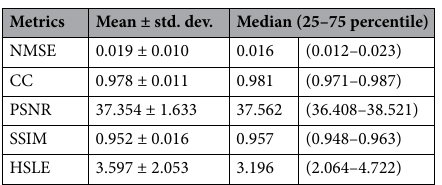
Table 3. Summary of testing the method over a synthetic dataset with a single low-temperature heat source.